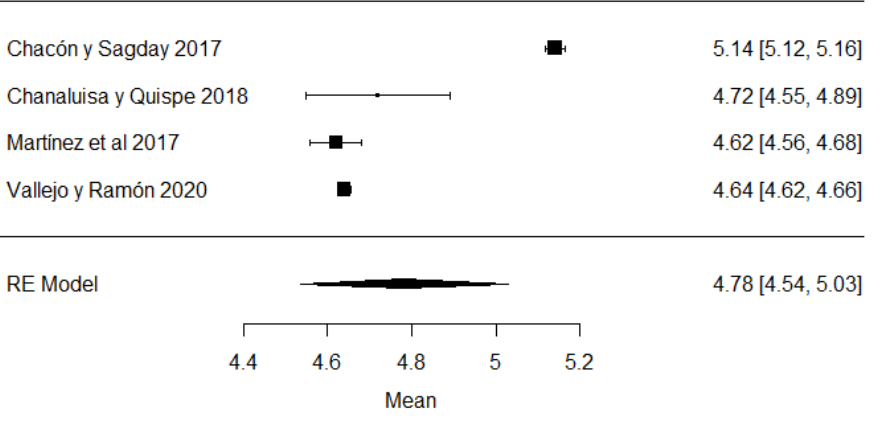
Figure 7. Lactose forest plot [42,51,57,77].